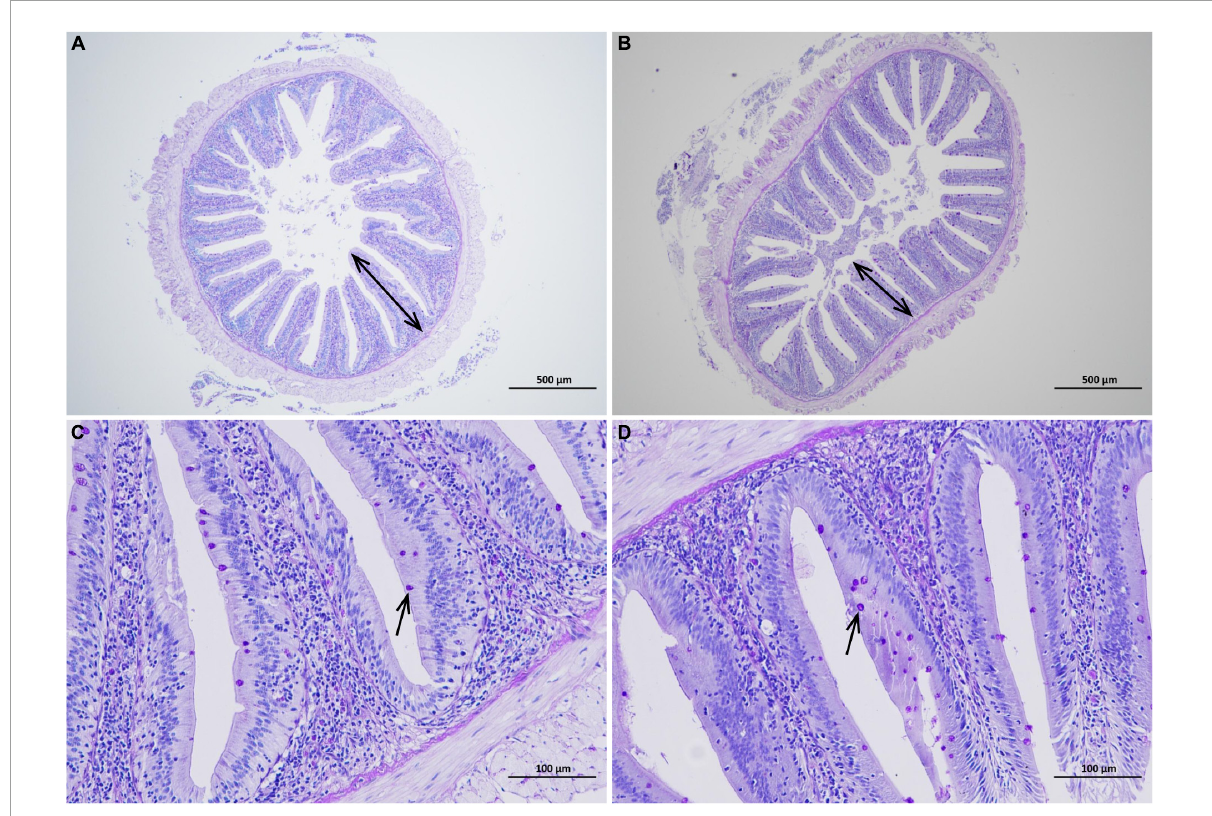
FIGURE4 Effects of chlorogenic acid (CGA) on the intestinal morphology. (A) Observation of intestinal morphology in the control group under a 40 magnification microscope. (B) Observation of intestinal morphology in the experimental group under a 40 magnification microscope. (C) Observation of intestinal morphology in the control group under a 200 magnification microscope. (D) Observation of intestinal morphology in the experimental group under a 200 magnification microscope. Arrows in panels (A,B) indicate villus height. Arrows in panels (C,D) indicate goblet cells.